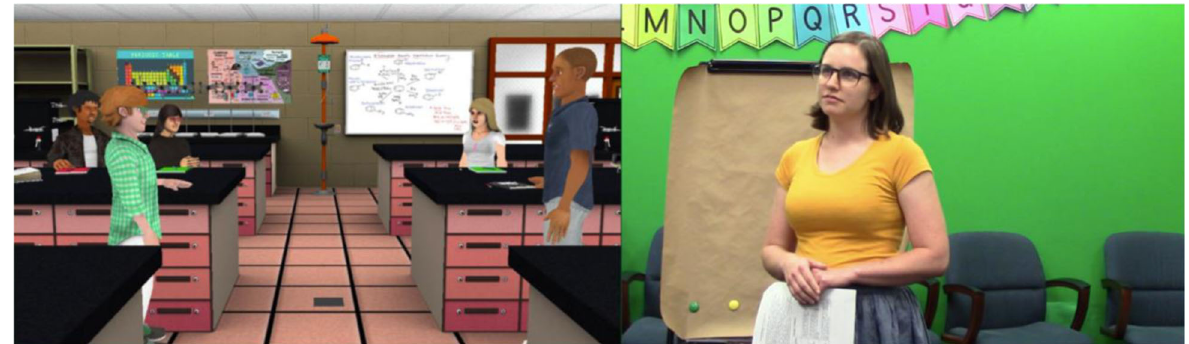
FIG. 2. A virtual classroom with five student avatars (on the left), and a researcher (acting as a GTA) in a physical classroom (on the right) interacting with the student avatars that are projected on a big